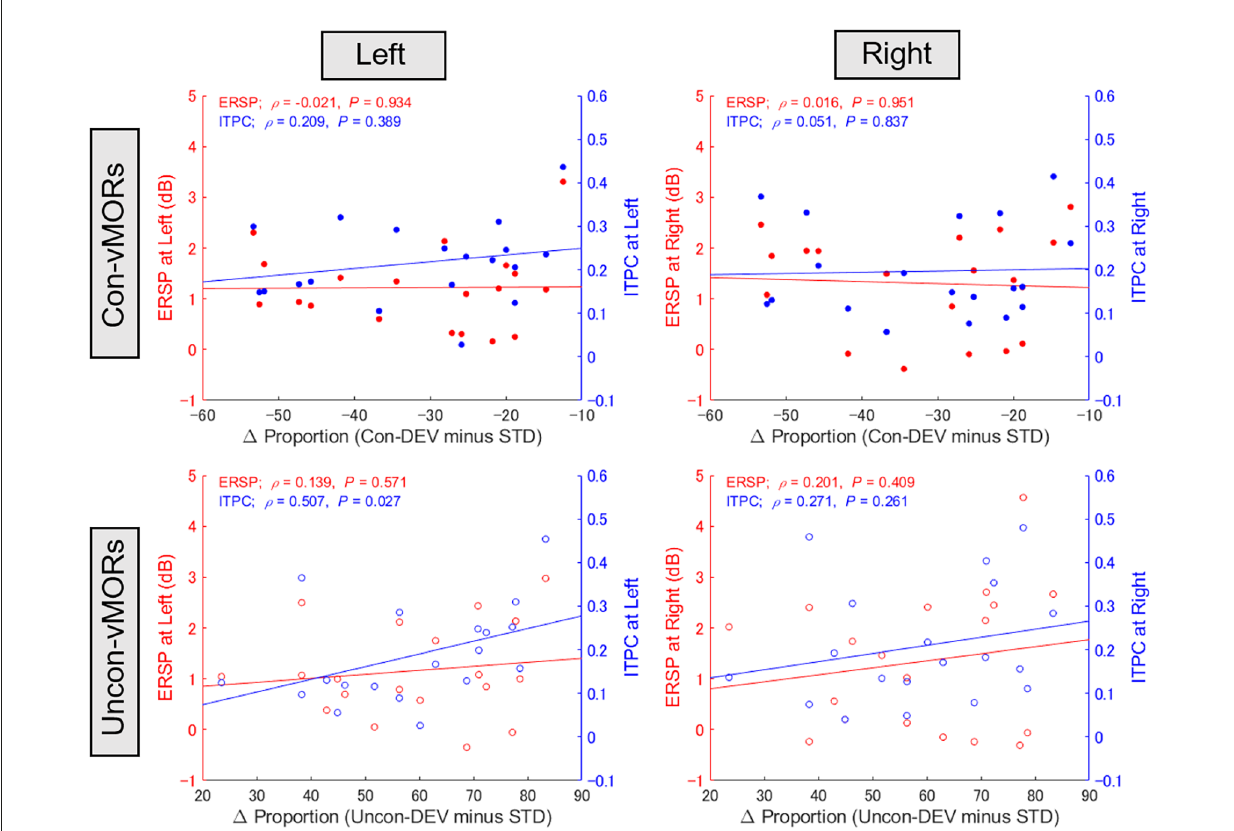
FIGURE5 Relationship between proportion of perceptual alternation and vMORs across participants. The correlations between the differential proportion of perceptual alternation (Uncon-DEV condition − STD condition; Con-DEV condition − STD condition) and ERSP/ITPC of vMORs in the theta band are shown for each condition (Con-vMOR in left: upper left panel; Con-vMOR in right: upper right panel; Uncon-vMOR in left: lower left panel; Uncon-vMOR in right: lower right panel). There was a significant correlation between the differential proportion and enhancement of ITPC in the left area under the Uncon-vMOR condition. Uncon-DEV,